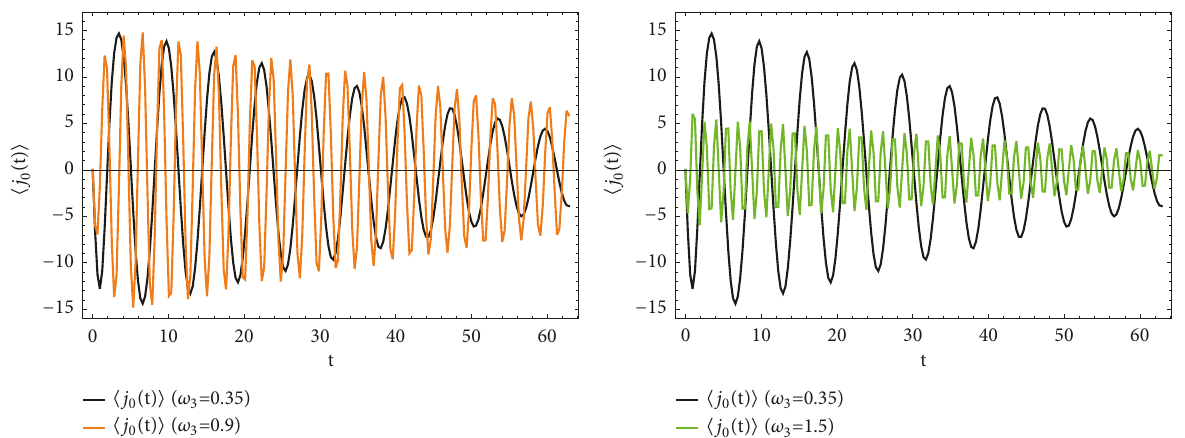
Figure 6: 𝐵 dependence for the time evolution of PNA. The horizontal axis is the dimensionless time defined as 𝑡 = 𝜔 푟 3, 0 (𝑥 0 − 𝑡 0 ) . As a reference angular frequency, we choose 𝜔 푟 3, 0 = 0.35 . We use a set of parameters as (̃𝑚 2 , 𝑇,𝐻 푡 the left plot, the black and magenta lines display the cases 𝐵 = 1.58 and 1.01 , respectively. For the right plot, the black and blue lines display the cases 𝐵 = 1.58 and 0.76 , respectively.